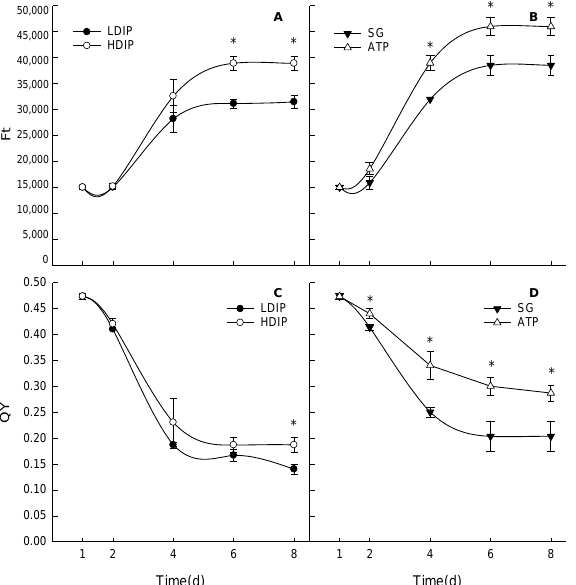
Figure 2. Changes in the chlorophyll fluorescence parameters Ft and QY of C. roscoffensis in the groups of inorganic ( A , C ) and organic ( B , D ) initial phosphorus resources. (LDIP): low concentration of inorganic phosphorus; (HDIP): high concentration of inorganic phosphorus; (SG): Na 2 -glycerophosphate; (ATP): adenosine triphosphate. * statistical significance, p < 0.05.